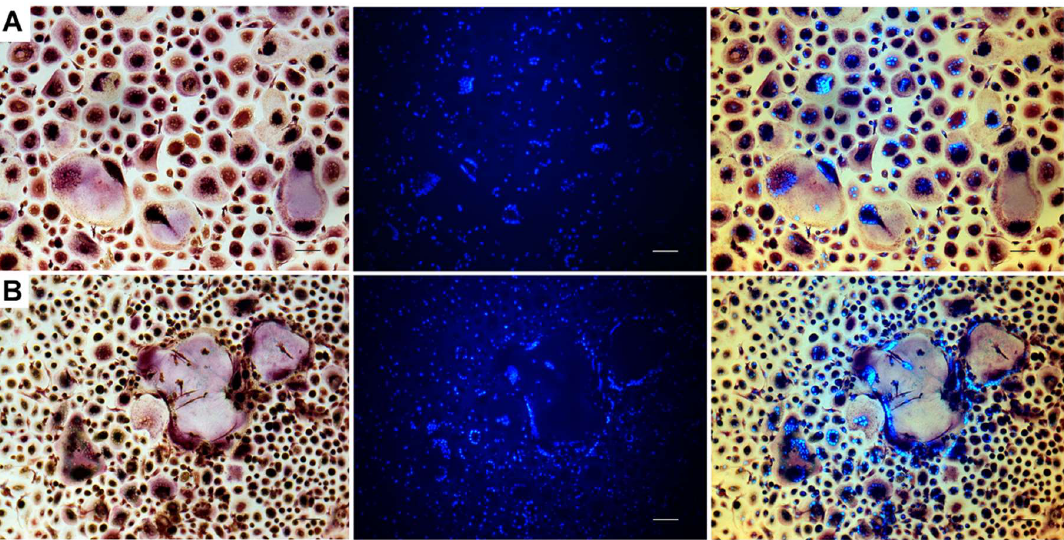
Figure 1. Tartrate resistant acid phosphatase (TRAP) and Hoechst staining of negative and positive controls on day 28. Peripheral blood mononuclear cells (PBMCs) cultivated without ( A ) and with ( B ) additional macrophage colony-stimulating factor (MCSF) and receptor activator of NF-κB ligand (RANK-L) respectively stained for TRAP and with Hoechst. Photos were taken using a light microscope (left), a fluorescence filter (middle), and a combination of both (right). TRAP positive multinucleated cells (MNCs) of various sizes, irrespective of the presence of MCSF- and RANK-L. Bar represents 100 µm.